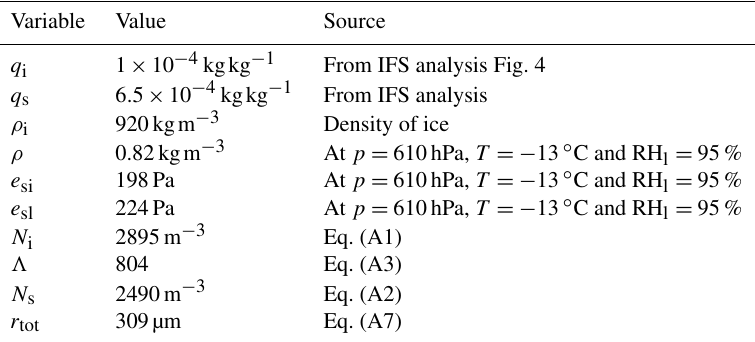
Table A1. Values of the different variables used in the computation of U ∗ z . Data from IFS analysis and radiosoundings at 09:00UTC are used. The pressure p used is 610hPa; temperature T is − 13 ◦